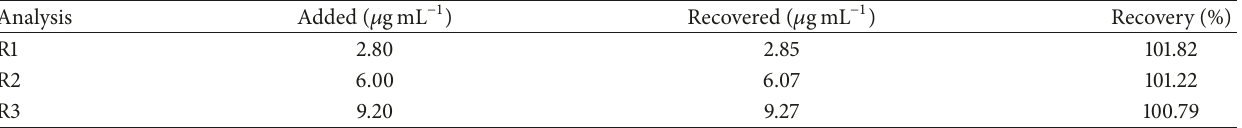
Table 1: Recovery test of ceftriaxone sodium powder for injection.